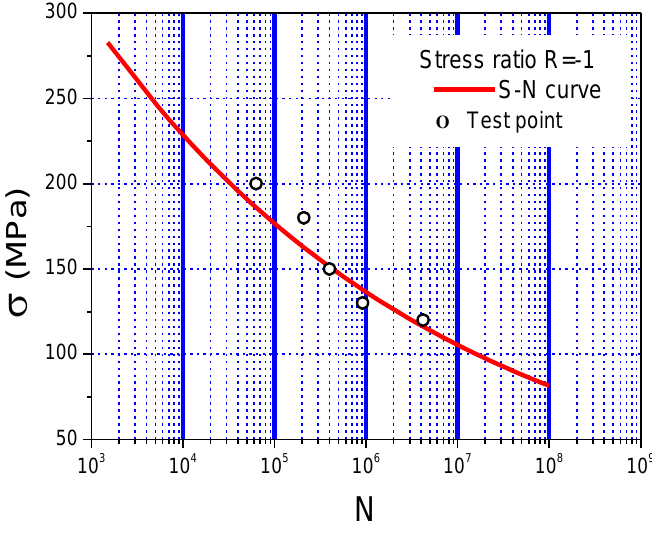
Figure 14. Comparison results of test points and S-N